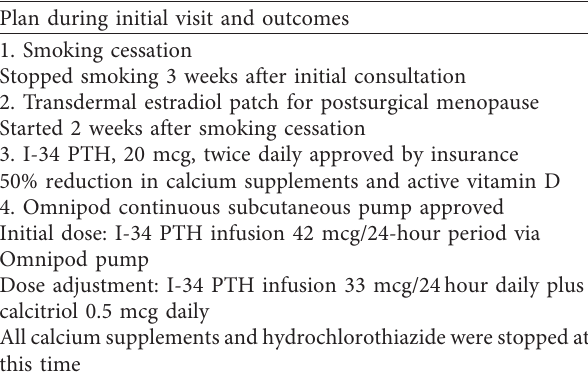
Table 2: Plan during initial visit and outcomes. Plan during initial visit and